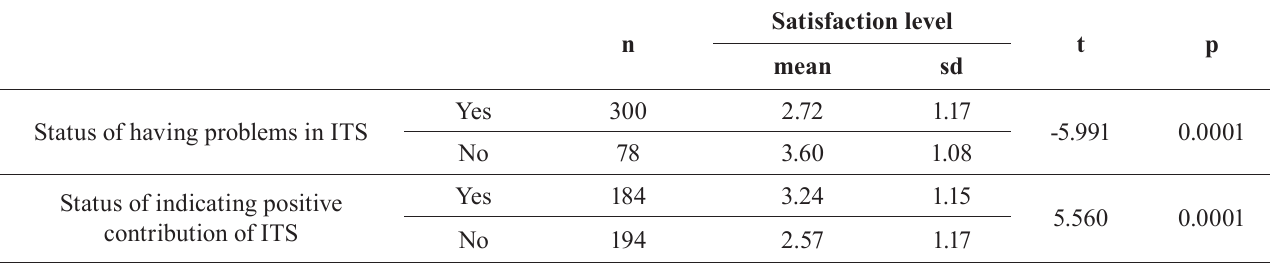
Satisfaction level n